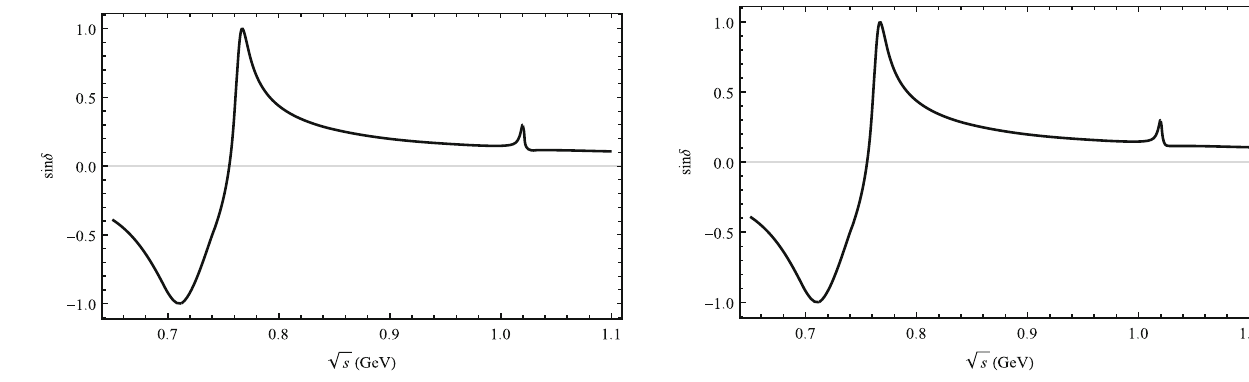
Fig. 6 Plot of sin δ as a function of parameter values of CKM matrix elements for the decay channel of ¯ B 0